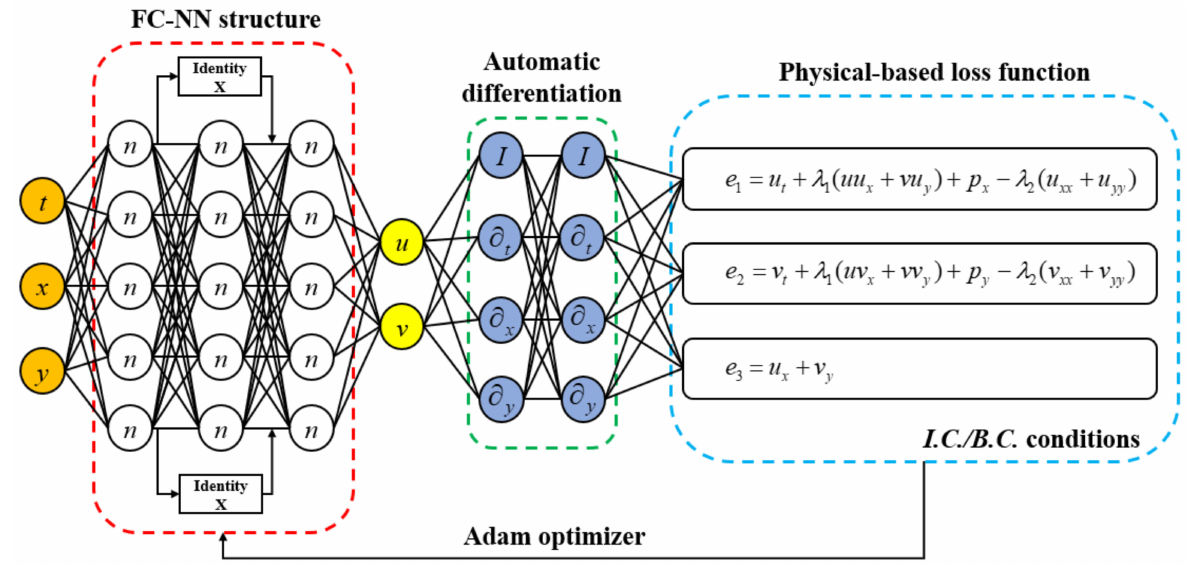
Figure 12. Naiver-Stokes informed neural network (flow past cylinder).